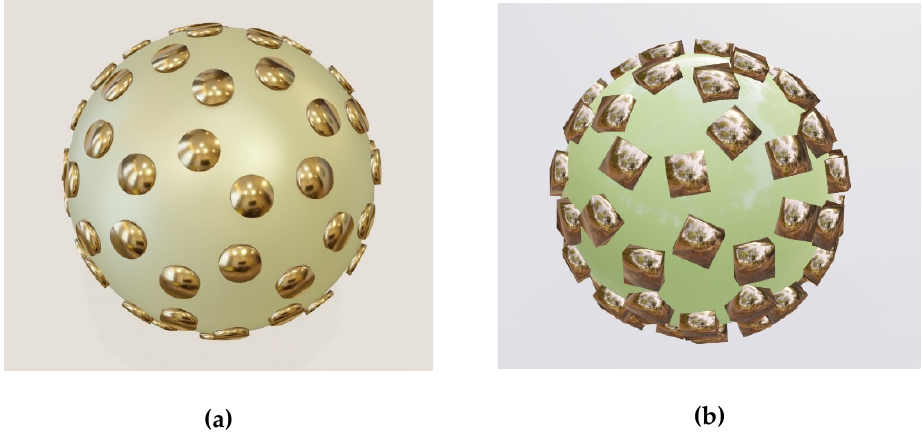
Figure 5. Brochosome-inspired plasmonic spheres made of dielectric with metallic surface nanoparticles corresponding to the holes in metal shell. ( a ) Low-height cylinders (disks) distributed across the surface in the form of a hexagonal lattice; ( b ) flattened square cuboids distributed across the surface in the form of a hexagonal lattice.